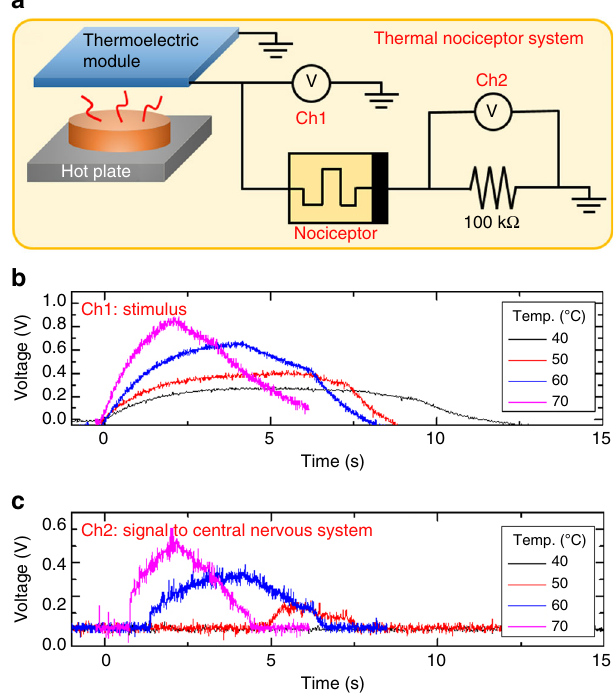
Fig. 6 Implementation of a thermal nociceptor. a Schematic diagram of the circuit of an arti fi cial thermal nociceptor consisting of a thermoelectric module and the diffusive memristor (threshold switch). b The generated voltage from the thermoelectric module and ( c ) the ON-switching and OFF- switching of the threshold switch monitored by Ch1 and Ch2 of the oscilloscope,